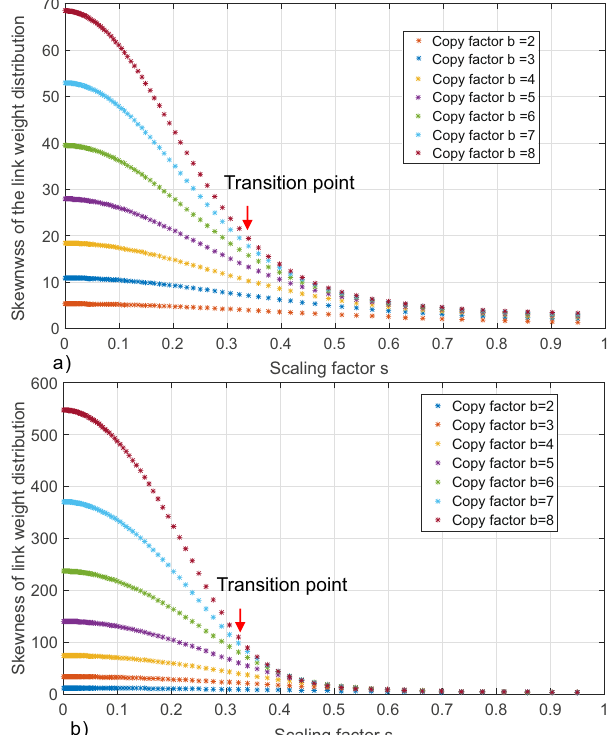
Figure 8. Skewness of link weight distribution of Sierpinski fractal network. ( a ) The skewness of link weight distribution of G 5 as function of scaling factor s and copy factor b = 2, 3, 4, 5, 6, 7, 8. ( b ) The skewness of link weight distribution of G 7 as function of scaling factor s and copy factor b = 2, 3, 4, 5, 6, 7,